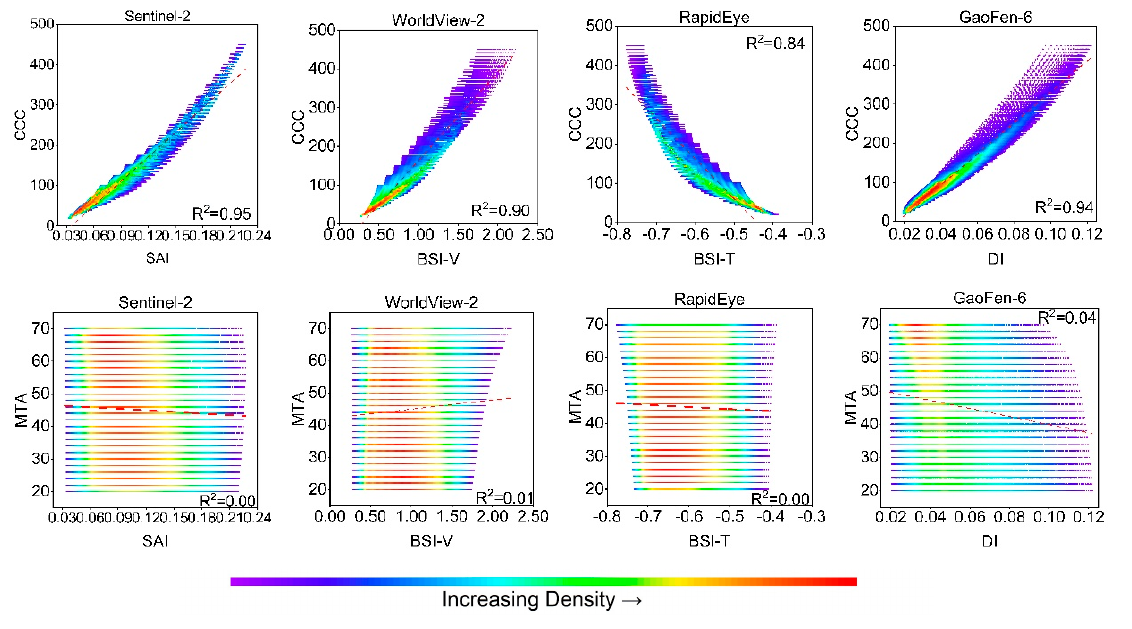
Figure 6. Correlation between the best vegetation indices, and CCC ( top row ) and MTA ( bottom row ) for Sentinel − 2 ( left column ), WorldView − 2 ( second column ), RapidEye ( third column ) and GaoFen ‐ 6 ( right column ) in model simulations.